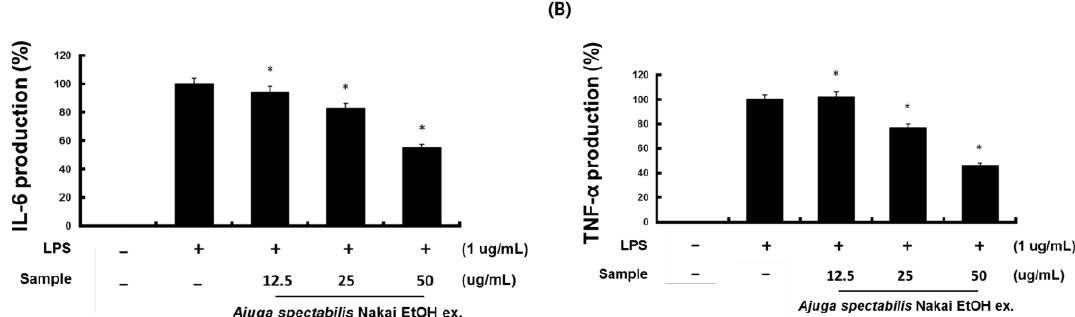
Figure 6. Inhibitory effect of AS-E on the production of IL-6 ( A ), TNF- α ( B ) in RAW264.7 cell. RAW264.7 cells were pre-treated with AS-E for 6 h and then co- treated with LPS (1 μg/mL) for 24 h. p < 0.05 compared to the cells without the treatment, and * p < 0.05 compared to the cells treated with LPS alone.